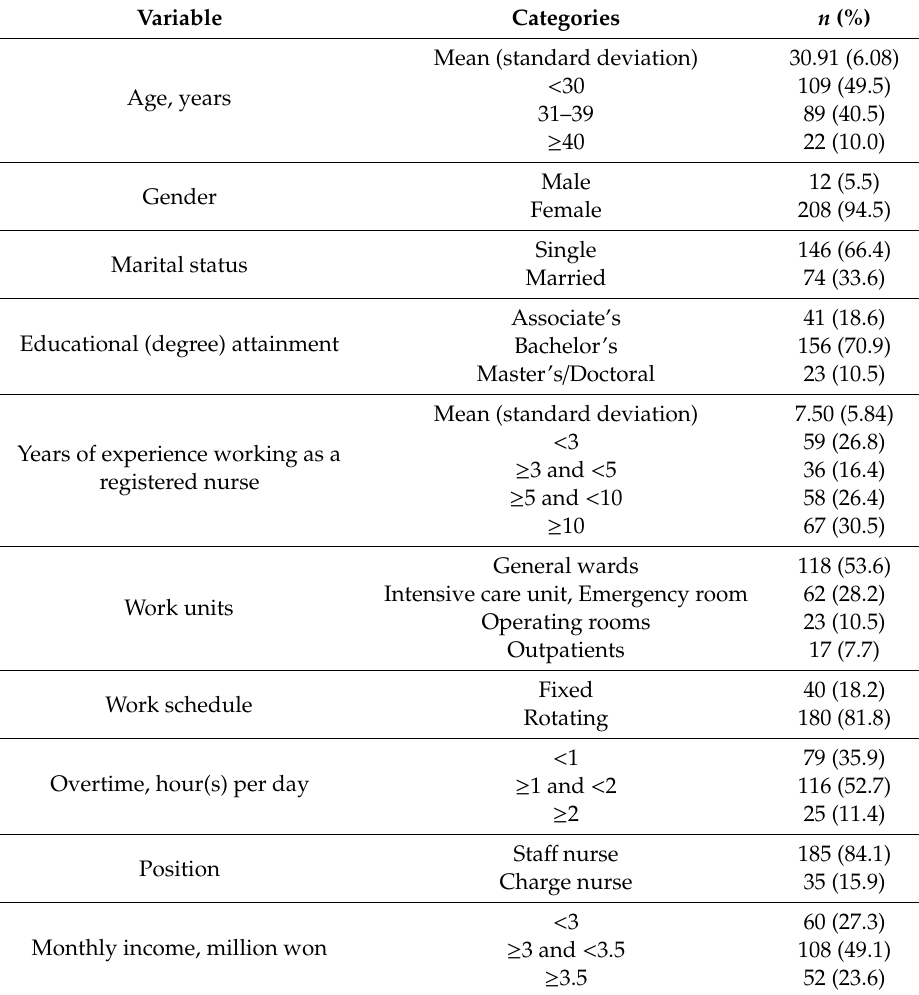
Table 1. Demographic characteristics of study